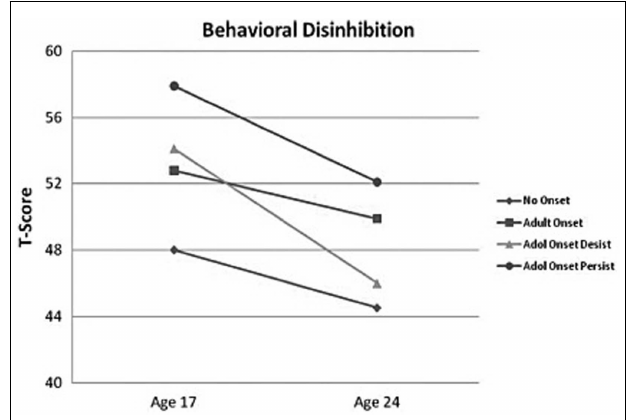
FIGURE 1 |The figure depicts the mean behavioral disinhibition scores for the alcohol-dependent groups (no onset, n = 1211; adult onset, n = 545; adolescent onset-desist, n = 71; and adolescent onset-persist, n = 149) at ages 17 and 24 (scores are in a T -score metric; mean = 50, SD = 10) . Adapted from Hicks et al., 2012; copyright 2011 by Addiction